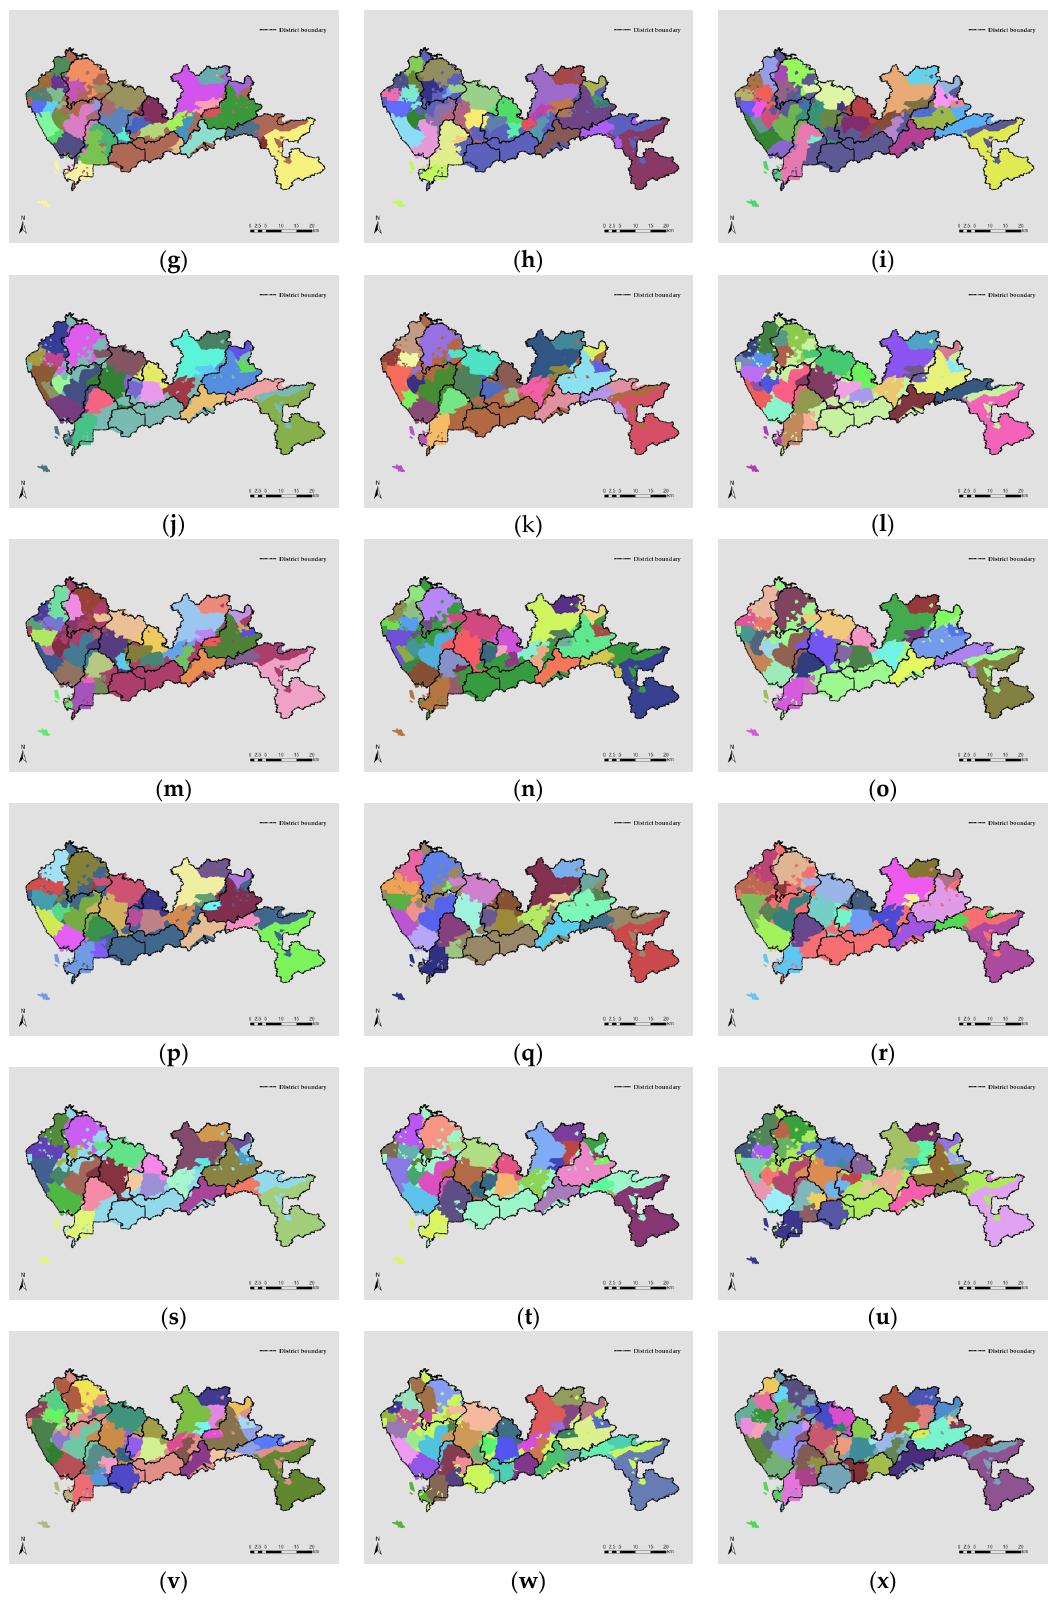
Figure A1. The complete list of figures showing the identified interaction-based structures for the whole day ( a ); and at different hours ( b – x ) from 12:00–1:00 a.m. to 10:00–11:00 p.m., in chronological order. Colors indicate the component affiliations of the spatial units.